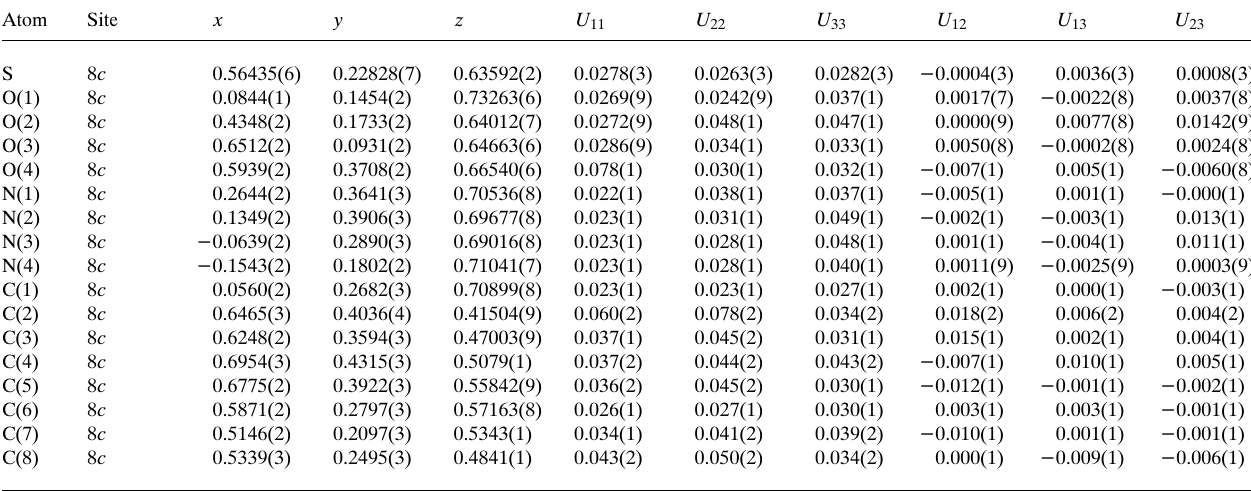
Table 3. Atomic coordinates and displacement parameters (in Å 2 ) .